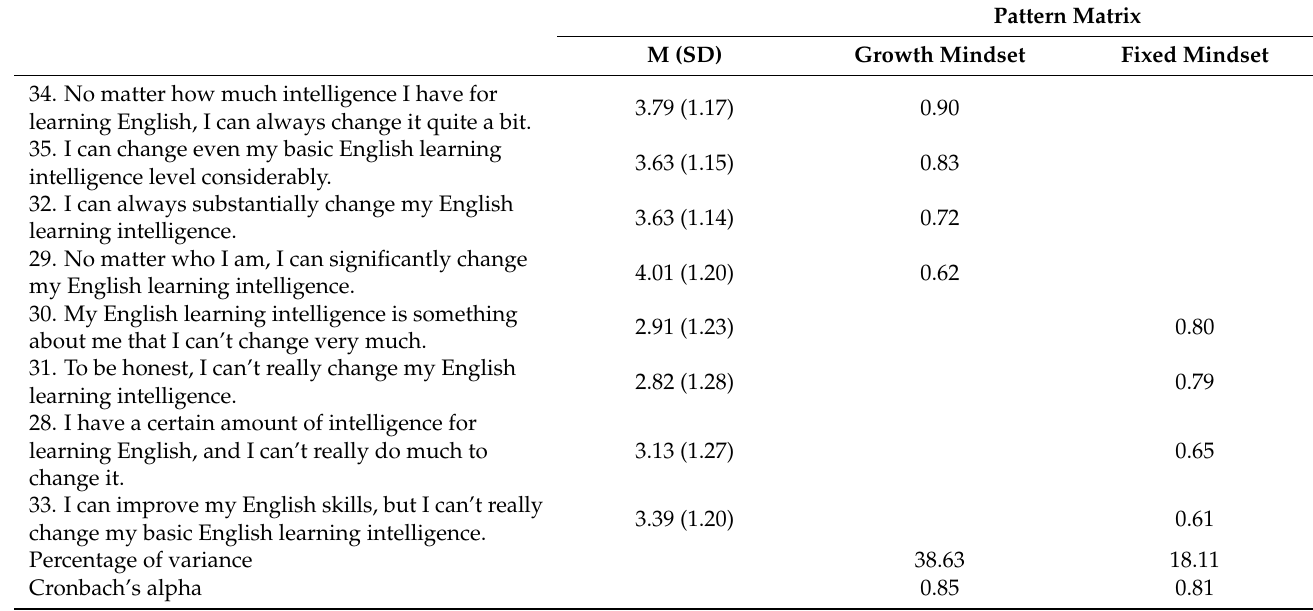
Table A3. Exploratory Factor Analysis of English Mindsets with Factor Loadings ≥ 0.30 Displayed.